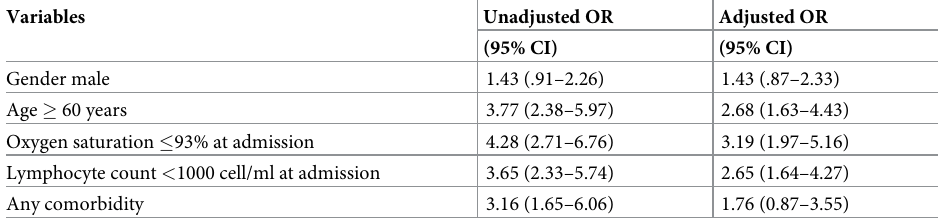
Table 6. Multivariable analysis of characteristics associated with death at 30-days among 809 patients hospitalized with COVID-19 in Argentina.